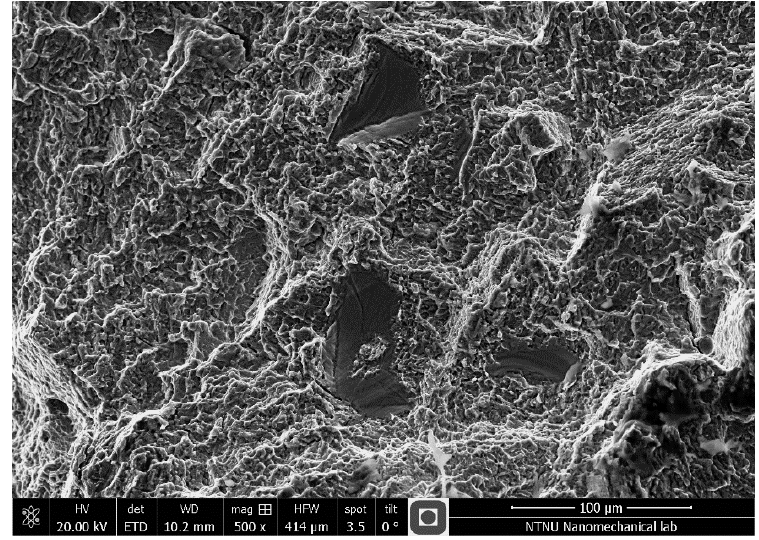
Figure 7. Fracture surface from a LENS porous flat specimen under uniaxial loading.